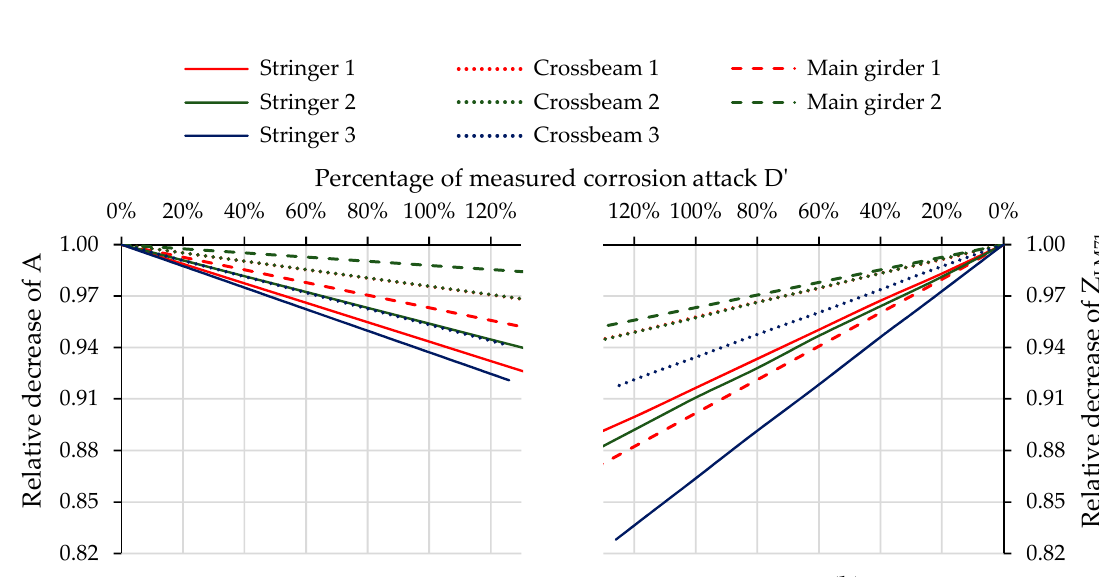
Figure 11. Relative decrease of the parameters of cross-sections as a function of the gradual increase of corrosion attack D’: ( a ) relative decrease of the cross-sectional area A; ( b ) relative decrease of the load-carrying capacity Z LM71 of the same cross-sections.